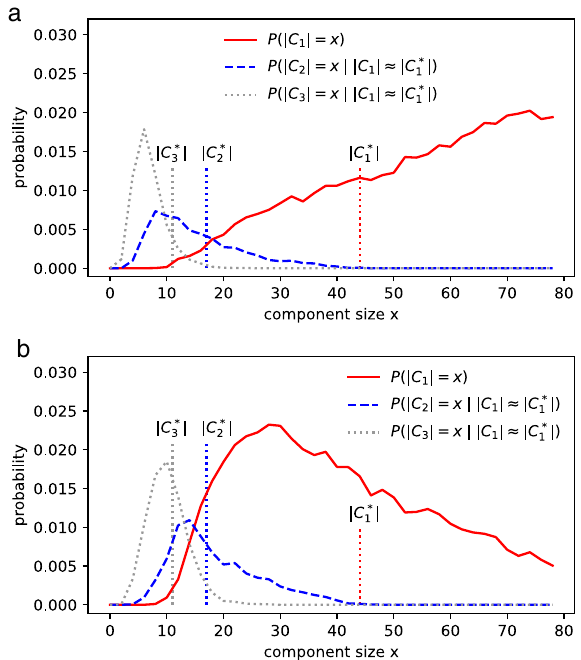
Figure 6. Fitting ER and PARG to the observed cluster sizes ( | C ∗ 1 | =44, | C ∗ 2 | =17, | C ∗ 3 | =11) in Tianjin. Both models contain 136 nodes and run 20,000 random realizations. ( a ) ER model has 93.1 edges. It reaches the maximum similarity ( T tri =0.0024) when p = 1.379 / n . ( b ) G ( 8.17 59 , 1.49 / n ) consists of 100.6 edges. The PARG has a much higher similarity T tri =0.00916.